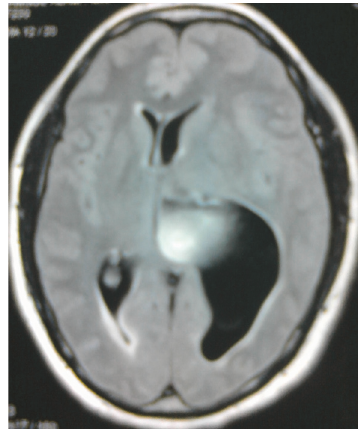
Figure 5: T1 image coronal view postcontrast film.